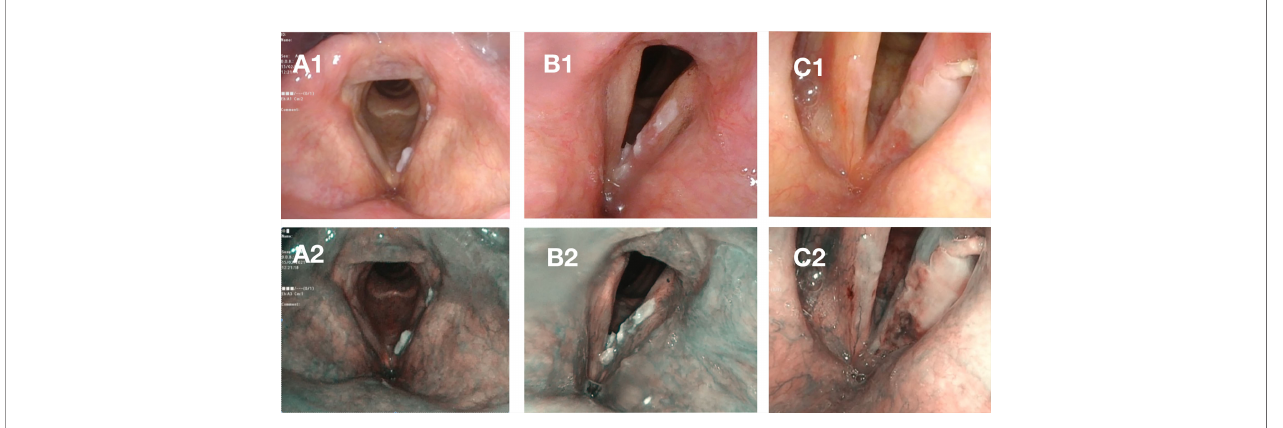
FIGURE 3 | Case A – elevated and smooth leukoplakia seen in white light [WL] (A1) and Narrow Band Imaging [NBI] (A2) with no evidence of neoplastic proliferation and only low-grade dysplasia in histopathological examination. Case B – elevated and rough leukoplakia in WL (B1) with pathologic vessels visible in the periphery of the plaque in NBI (B2) , high-grade dysplasia in histopathological examination. Case C – elevated and rough leukoplakia (C1) with pathologic vessels visible in the periphery of leukoplakia on the frontal part of the left vocal fold in NBI (C2) with invasive carcinoma in histopathological